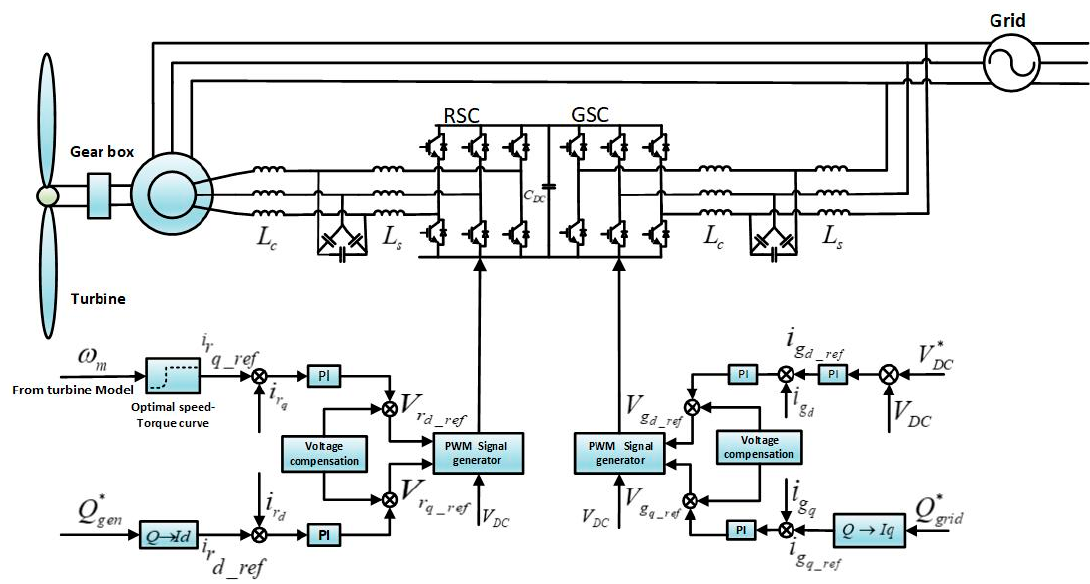
Figure 3. Control schematics for a DFIG wind turbine.